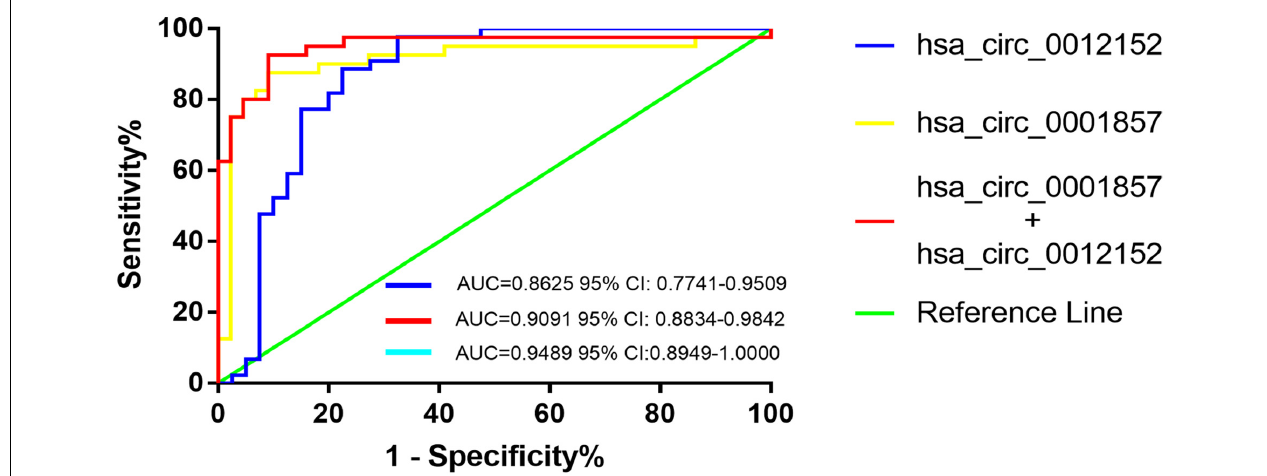
FIGURE 4 | The receiver operating characteristic (ROC) of hsa_circ_00012152 and hsa_circ_0001857 as classification biomarkers to discriminate acute lymphoblastic leukemia (ALL) from acute myeloid leukemia (AML).